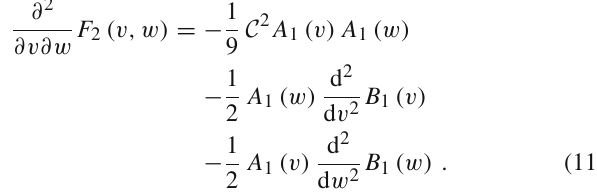
, which form an 0